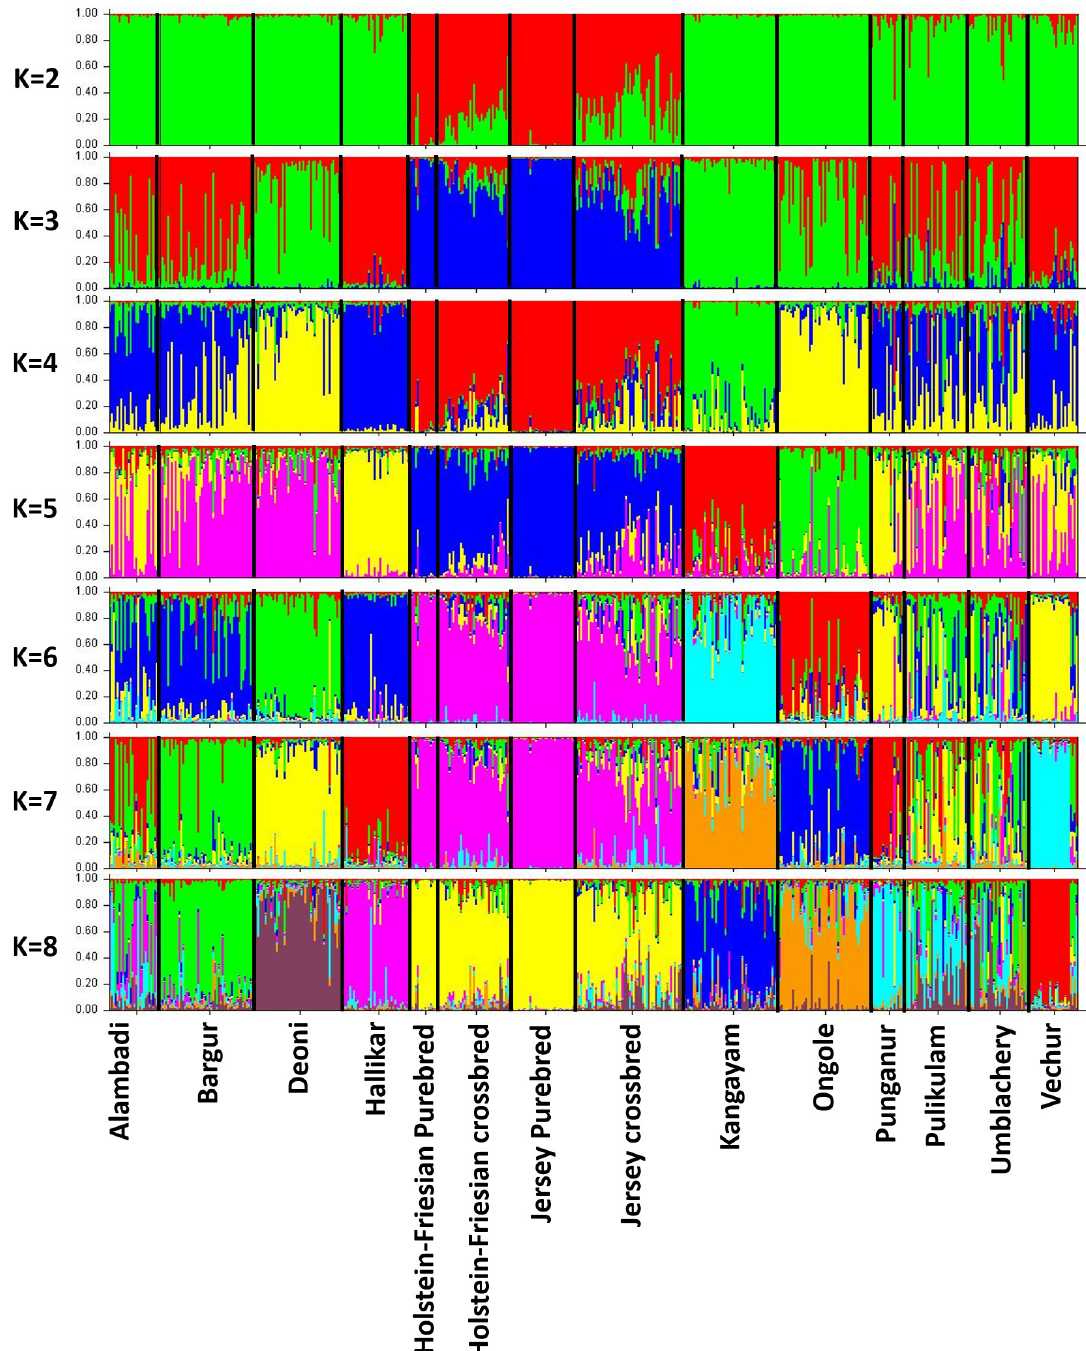
Fig 4. Bayesian clustering of 516 cattle under assumption of 2 to 8 clusters without a priori population information. The population names are given below the box plot with the individuals of different populations separated by vertical black lines. Hallikar, Bargur and Kangayam) and two belonged to T3 (one each from Deoni and Puliku- lam). The overall nucleotide diversity within I1 and I2 haplogroups were 0.0024 and 0.0029 respectively while the overall average number of nucleotide differences were 2.32 and 2.77